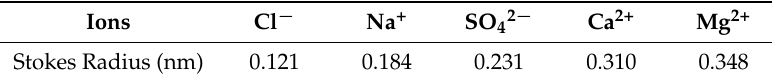
Table 1. Stokes radii of major ions used for calculations